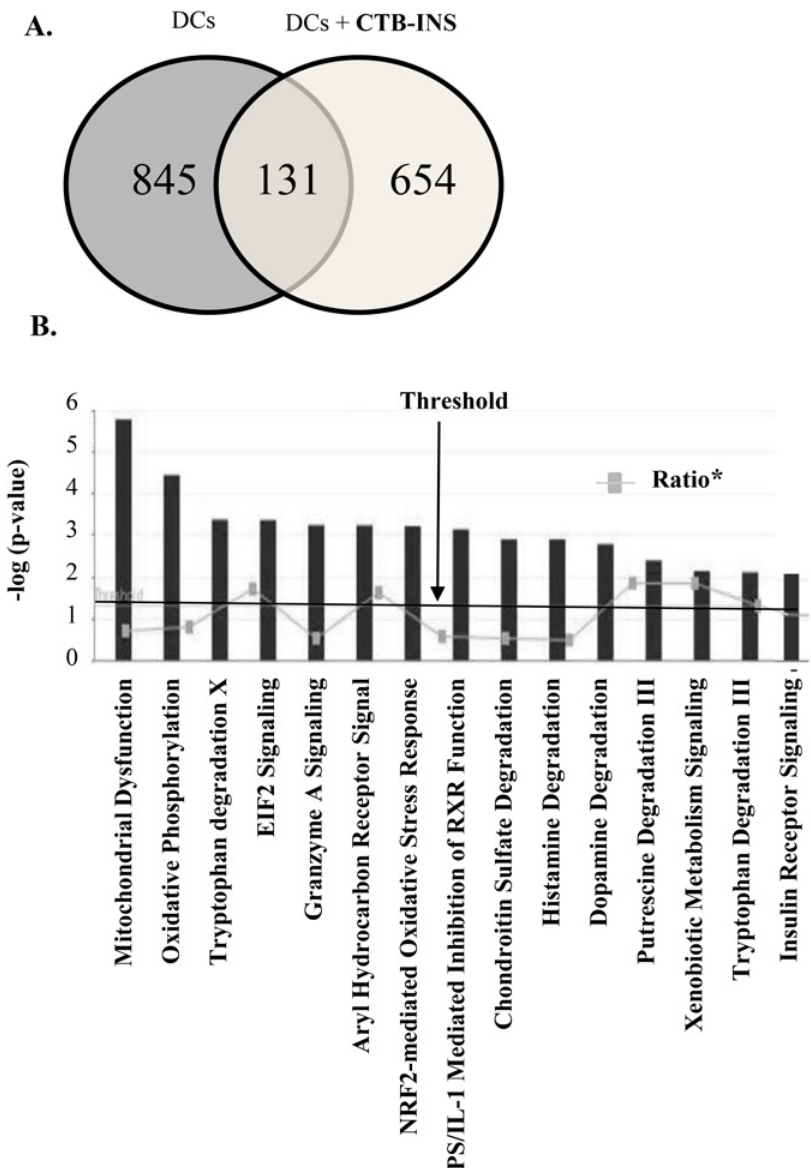
Fig 1. Mass spectrometric identification of the CTB-INS vaccinated DC proteome. (A) Venn diagram of significantly up or down regulated proteins in human monocyte derived dendritic cells inoculated with CTB- INS in comparison with monocytes as the baseline. A total of 845 proteins were identified in untreated DCs and 654 up and down-regulated proteins were unique in CTB-INS treated DCs, while 131 proteins were common to both treated and untreated DCs. (B) Canonical, metabolic and signaling pathways that correlate with changes in protein expression in CTB-INS vaccinated dendritic cells identified by IPA program analysis. The threshold line represents the value at which statistical significance is reported. The grey line connects the ratios between the number of up and down-regulated proteins over the total number of proteins identified in each of the pathways shown.